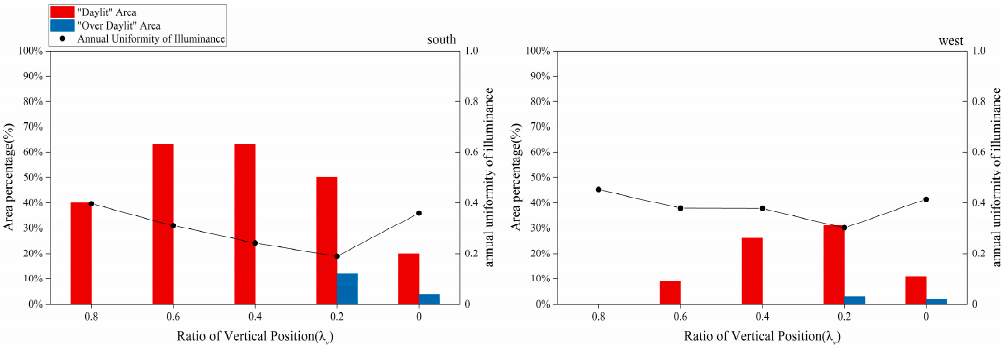
Figure 14. Distribution of over-day lit area in Group 3.